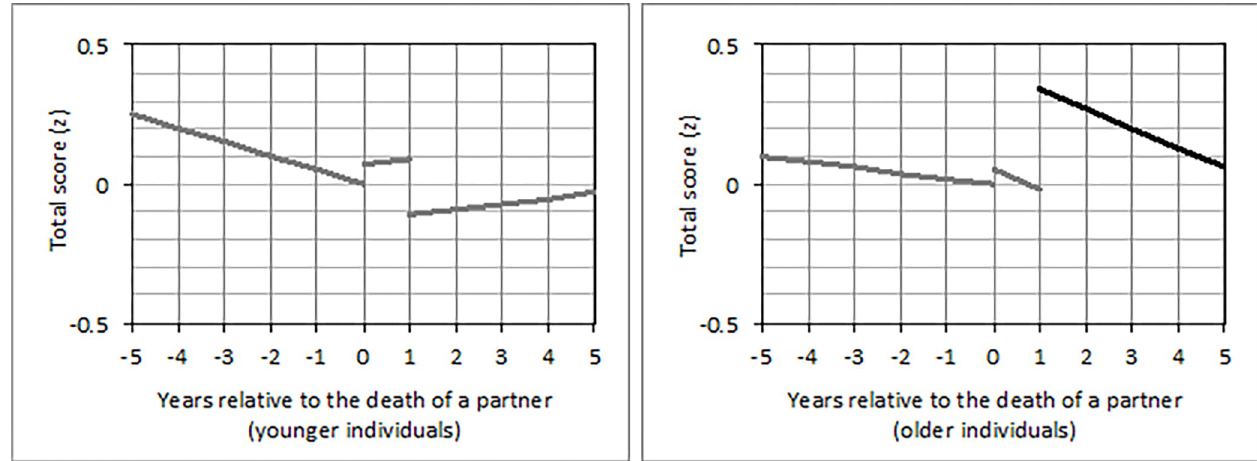
Fig 6. Changes of total control beliefs from five years before until five years after the death of a partner in (a) younger and (b) older individuals who experienced this loss between 1991 and 1999. Note . A detailed description of the figure can be found in Fig 2. The third line in (b) is marked in black because the long-term effect reached statistical significance ( p < .05) only in older but not in younger individuals.